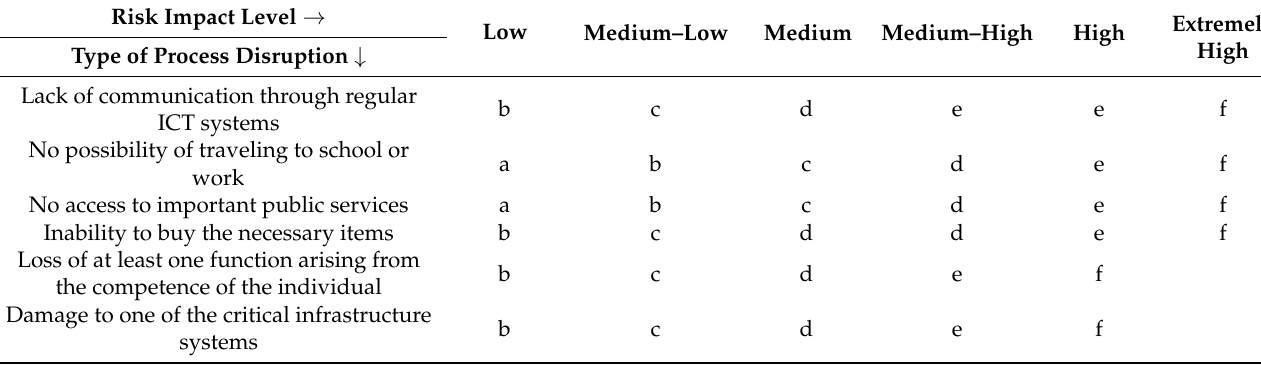
Table A6. Assessment of the everyday life disruption